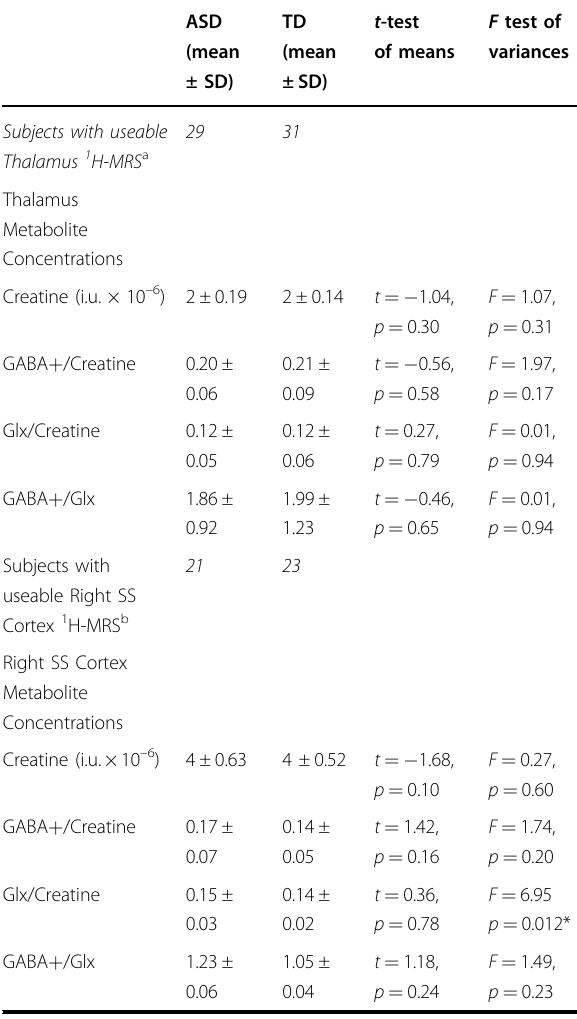
Table 2 1 H-MRS Metabolite